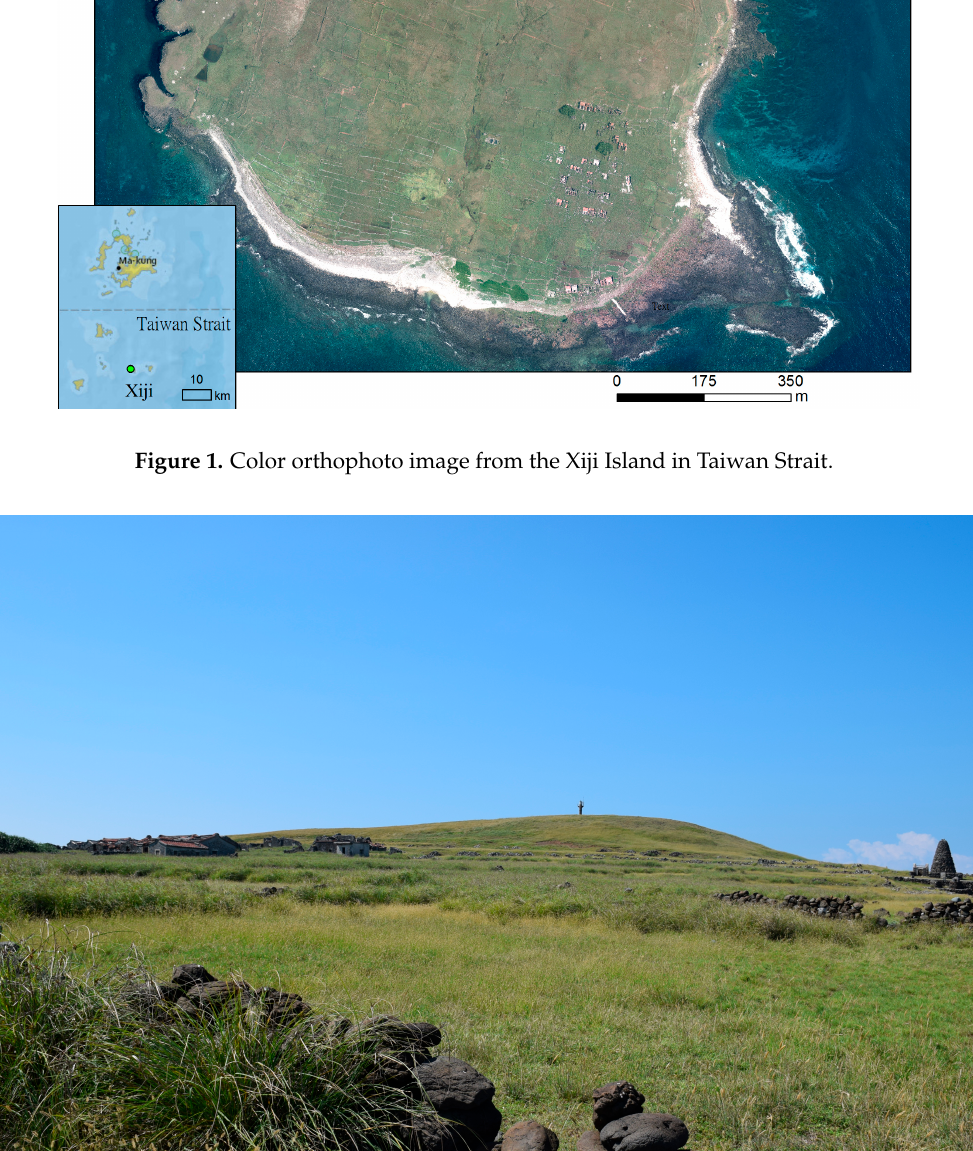
Figure 2. Vegetation garden wall.